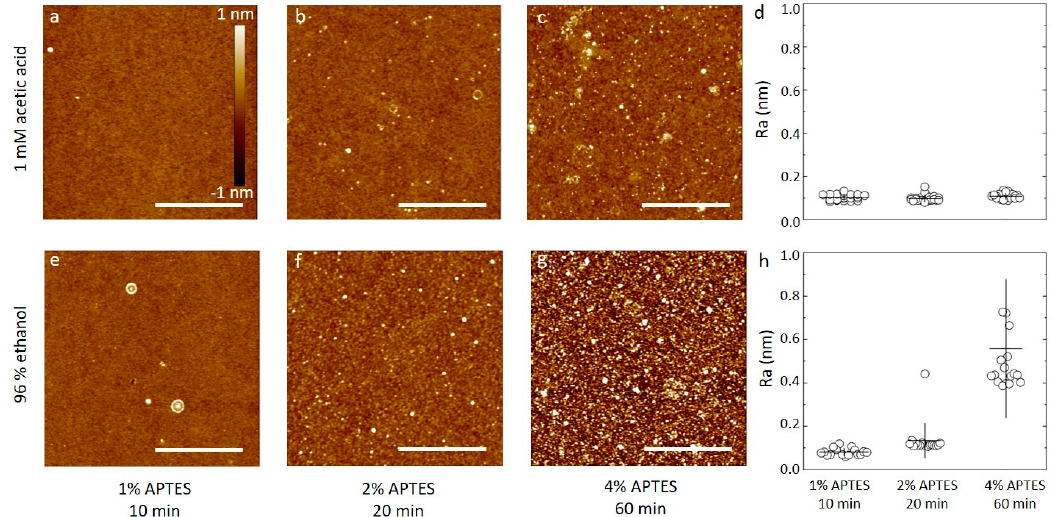
Figure 1. ( a – c , e – f ) A set of six AFM topographs of silicon oxide substrates silanized with APTES. The substrates are silanized using either 96% ethanol or 1 mM acetic acid as the solvent and the APTES concentration is varied from 1% to 4%, as indicated in the figure. The height scalebar for all topographs is shown in Figure 1a. Lateral scalebars are 1 µ m. ( d , h ) The average surface roughness of silanized substrates prepared similar to the topographs in ( a – c ) and ( e – f ). The average is calculated based on four separate areas imaged on each of four samples prepared for each combination of solvent and APTES concentration parameters.